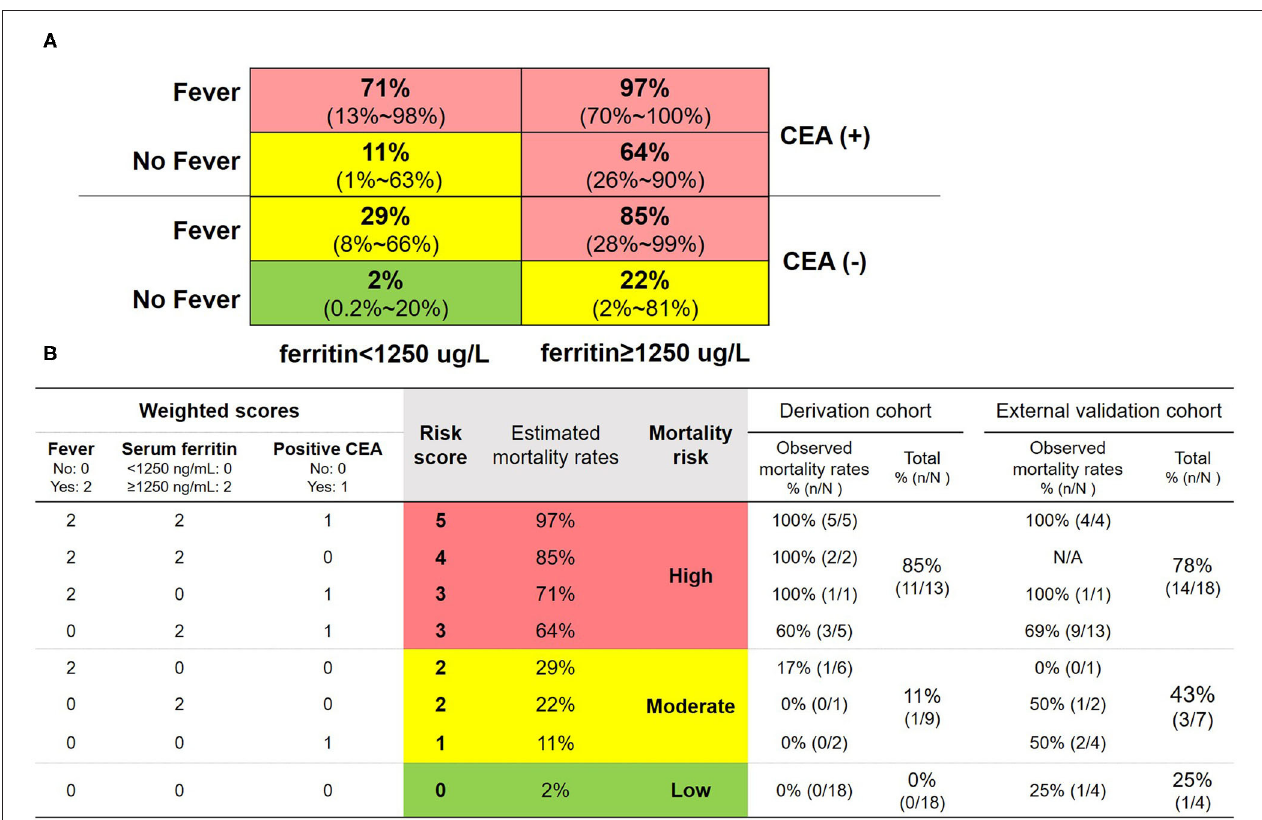
FIGURE 4 | Matrix prediction model and the corresponding scoring system for 6-month all-cause mortality in patients with anti-MDA5-positive DM. (A) Matrix prediction model: fever yes or no, carcinoembryonic antigen (CEA) positive or negative, and ferritin < 1,250 ug/L or ≥ 1,250 ug/L were combined to generate a matrix, and then, the relative mortality risk probability of death within 6 months in each grid was calculated. The 95% confidence intervals of the probabilities were shown in the parentheses. (B) Scoring system: three risk factors were weighted by regression coefficients, which were rounded into integer values. That is, fever scored 2 (yes) or 0 (no), serum ferritin scored 2 ( ≥ 1,250 µ g/L) or 0 ( < 1,250 µ g/L), and positive CEA scored 1 (yes) or 0 (no). The risk score was defined by adding the weighted scores of all three risk factors. Estimated and observed mortality rates of various combinations and two cohorts were shown. Red grids indicated high risk with the estimated mortality > 50% or 3–5 risk scores. Yellow grids indicated moderate risk with the estimated mortality between 49–10% and 1–2 risk scores. Green grids indicated low risk with the estimated mortality < 10% or 0 risk